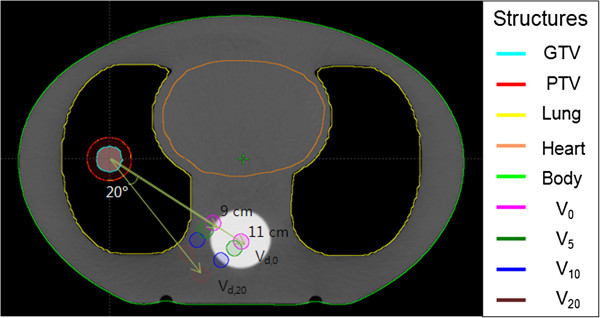
A phantom computed tomography (CT) image and delineated planning target volume (PTV) and organs at risk (OARs). The clinical target volume (CTV) overridden with 75 Hounsfield Unit value, the PTV created by adding a 5 mm-margin to the CTV, and the OARs (including the lung, the heart, and the spinal cord) were contoured on the phantom CT image sets. A set of 8 simulated spinal cord volumes were placed in different distances with 4 located 9 cm from the isocenter, and the other 4 at 11 cm from it. When a line connecting the isocenter and the original spinal cord in the phantom was chosen as the 0° azimuthal angle, and the other simulated spinal cords were positioned at 0°, 5°, 10°, and 20° in the clockwise direction. Each volume is denoted as Vds,Θ, where ds is the distance from the isocenter to each spinal cord, and Θ is the azimuthal angle.